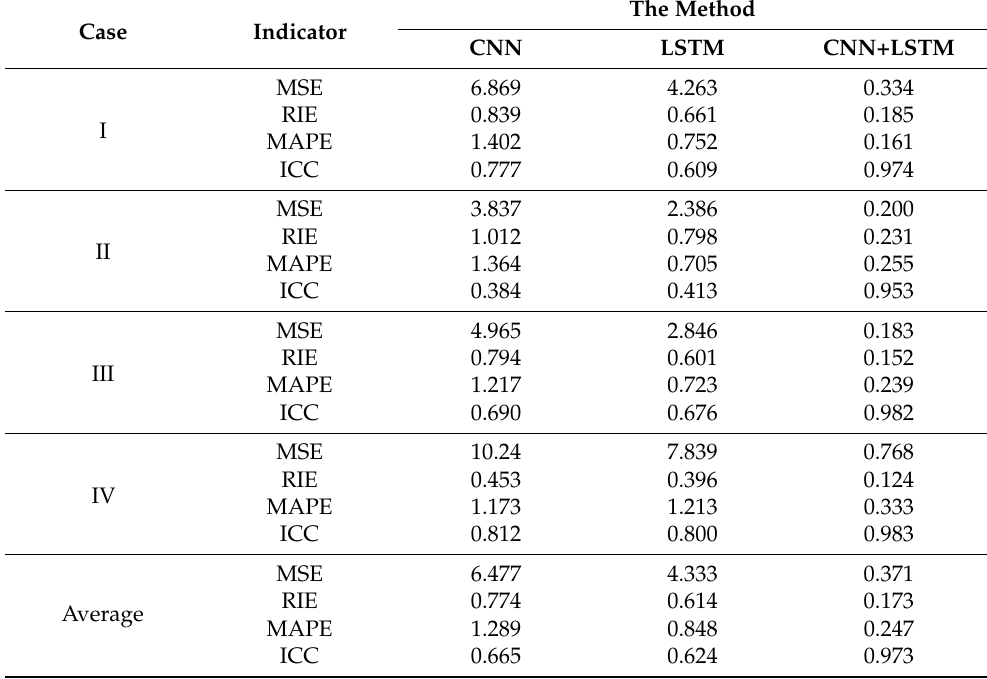
Table 6. Indicators characterizing the quality of reconstructions for individual methods and variants.